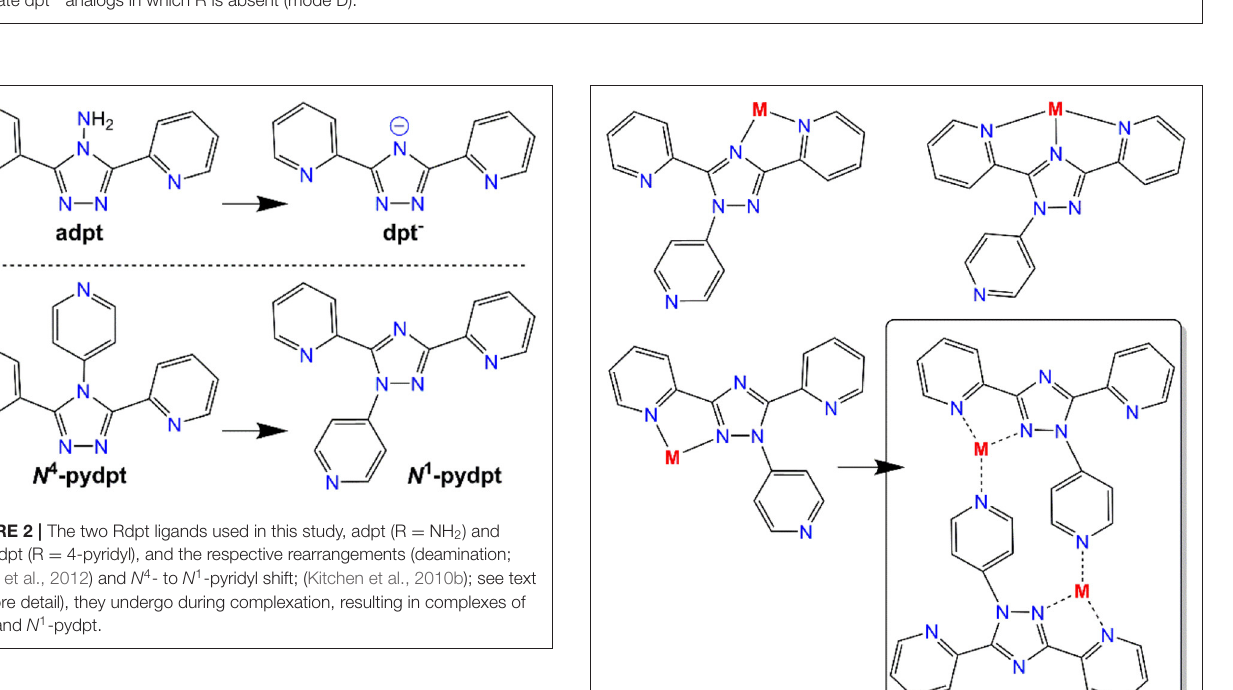
FIGURE 1 | Some of the binding modes observed for R-substituted-3,5-dipyridyl-4H-1,2,4-triazole type ligands (Rdpt), including a binding mode only available to the triazolate dpt − analogs in which R is absent (mode D).